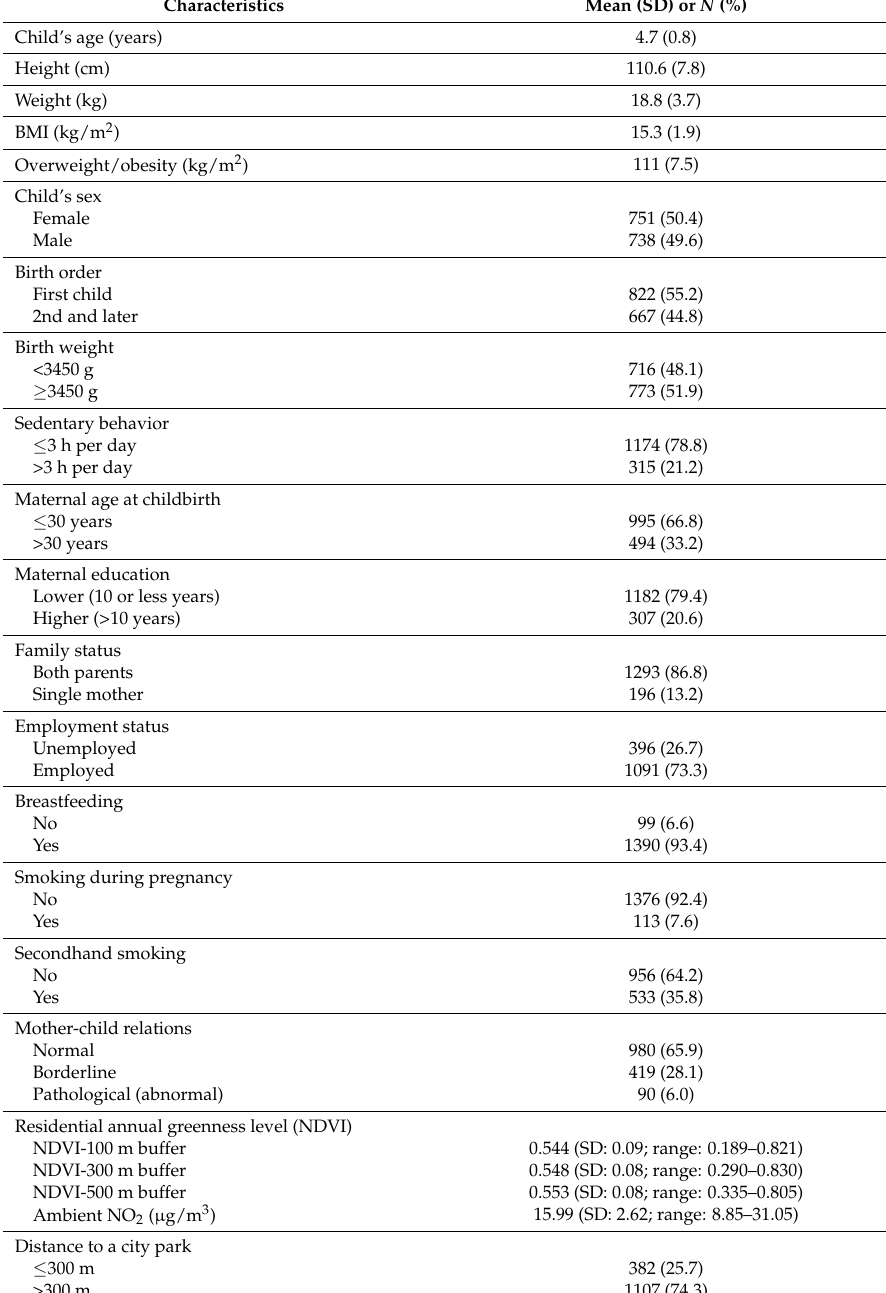
Table 1. Characteristics of study